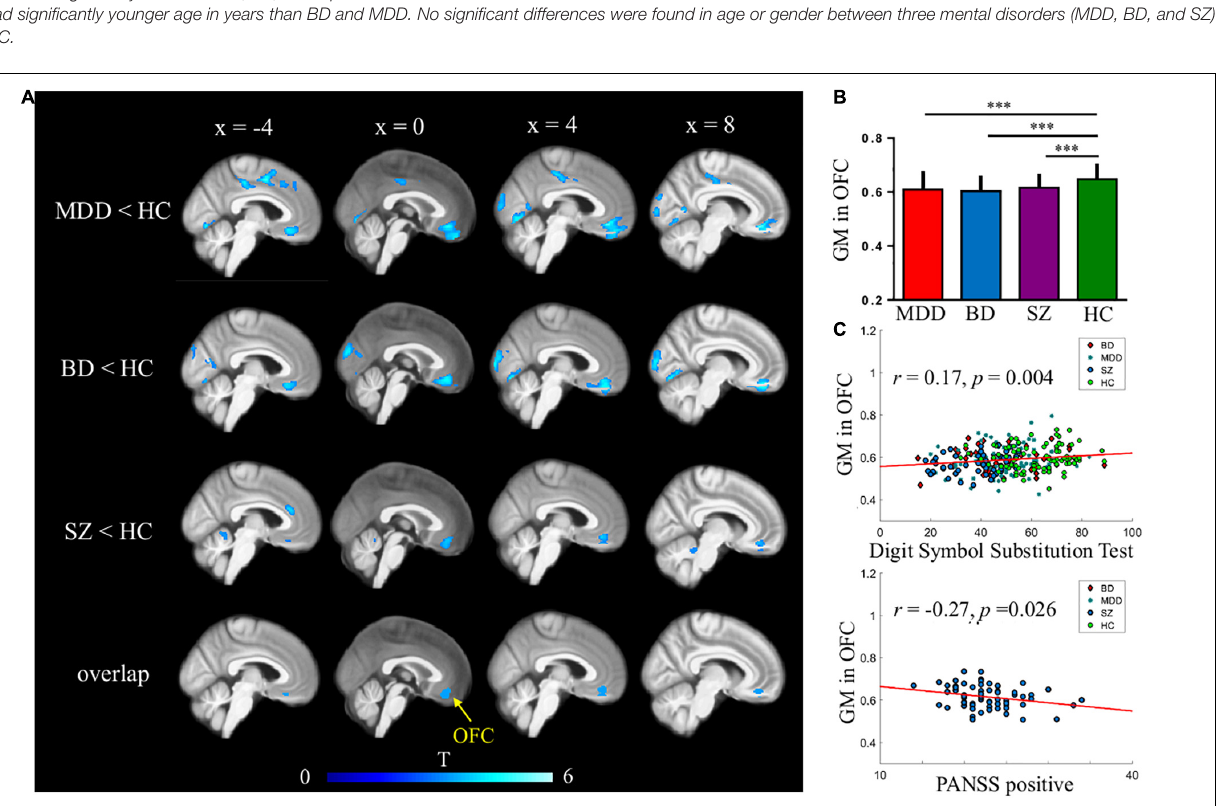
FIGURE 1 | Common gray matter (GM) deficits in major depressive disorder (MDD), bipolar disorder (BD), and schizophrenia (SZ). (A,B) Reduced GMVs were found in the medial orbitofrontal cortex (OFC) across three mental disorders. AFNI’s AlphaSim was used for multiple comparisons corrections; (C) GMVs in medial OFC were correlated with digit symbol substitution test across four groups and PANSS positive scales in patients with